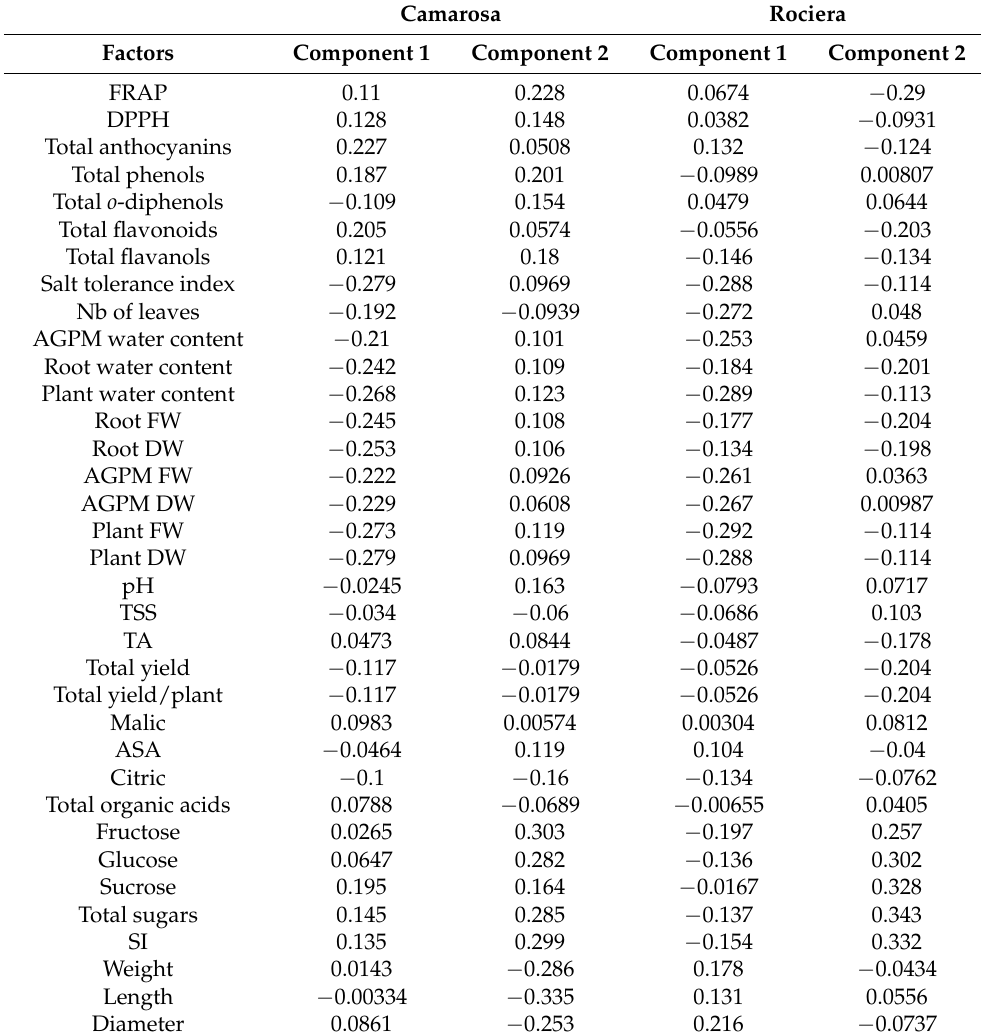
Table 11. Component weights in principal component analysis based on the measured physiological and biochemical